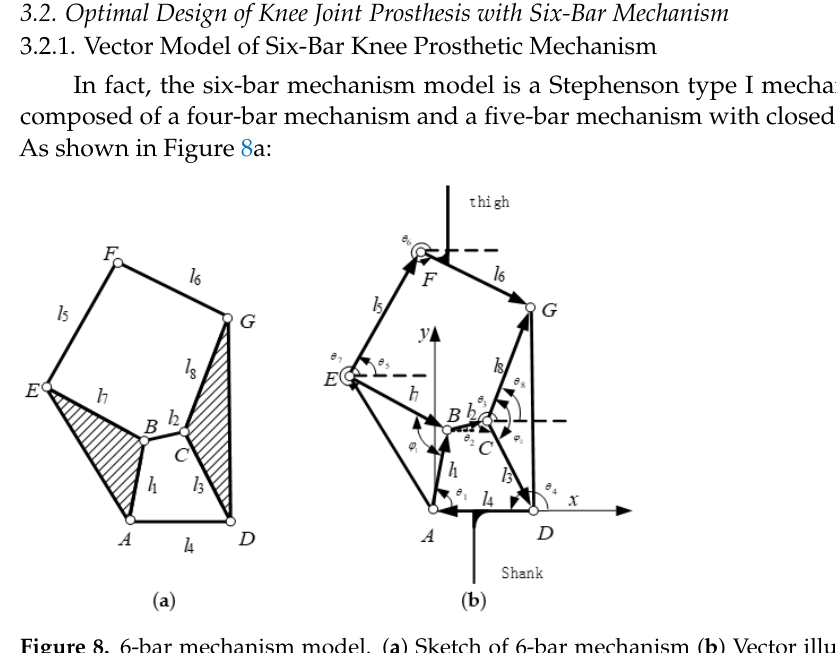
Figure 7. Common mechanism of multi-rod mechanism in prosthesis. ( a ) 4-bar mechanism, ( b ) 5-bar mechanism, ( c ) 6-bar mechanism.